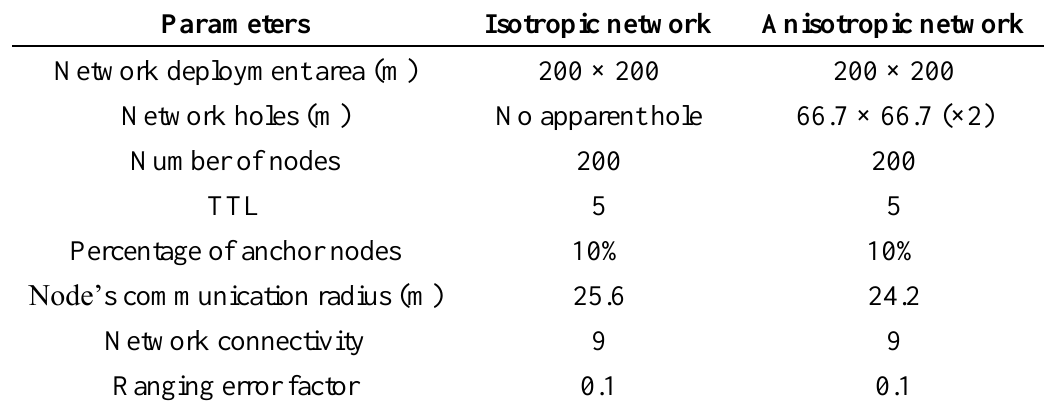
Table 1. Default parameters of